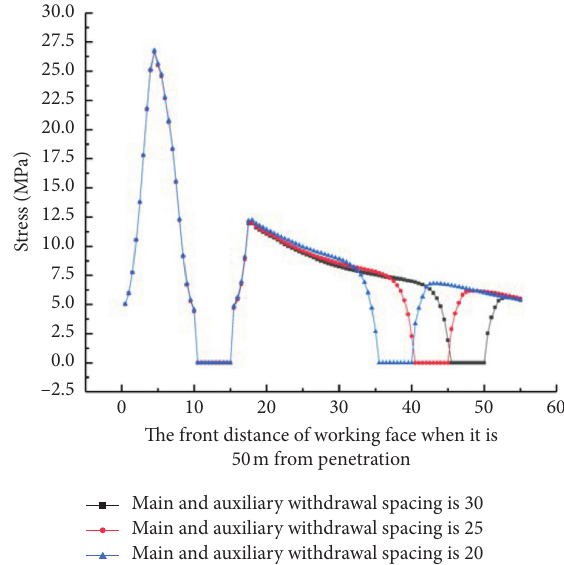
Figure 16: Vertical stress curve when Panel 31113 is 10m from